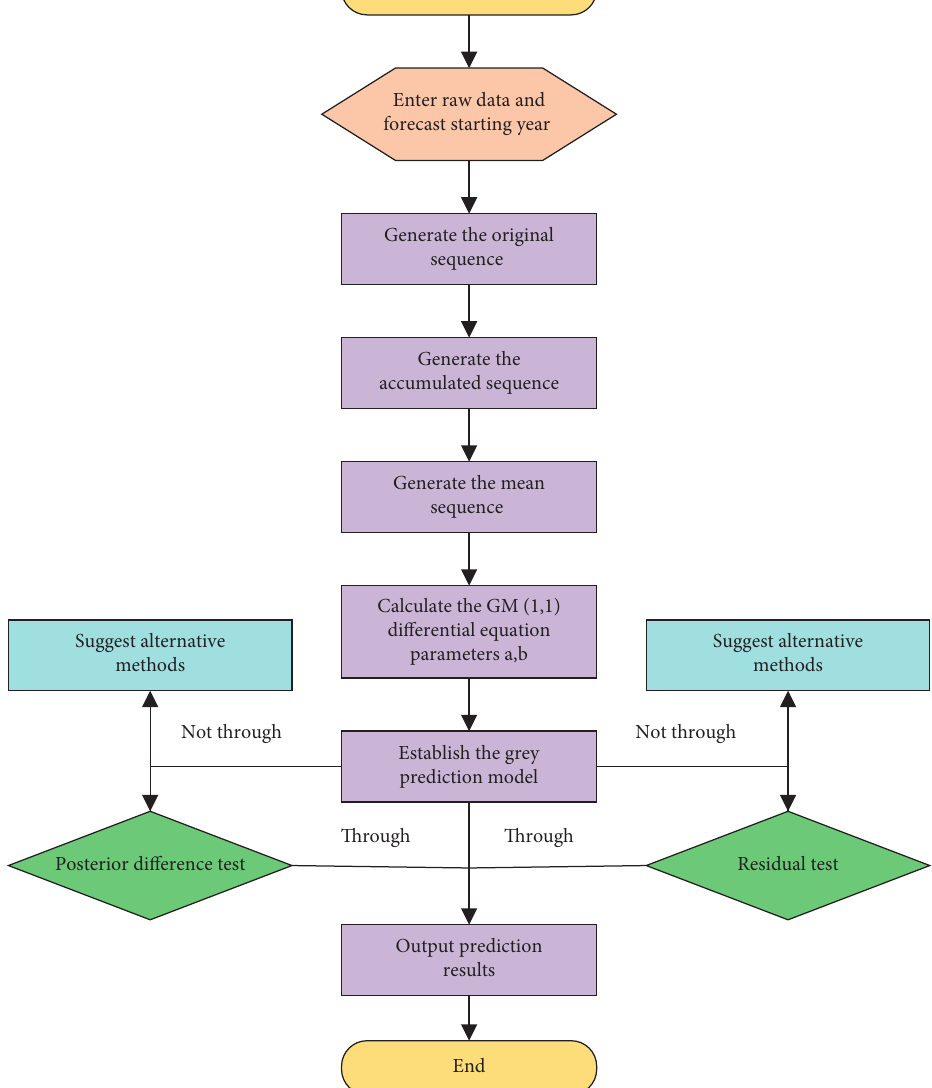
Figure 2: Modeling flowchart of the grey prediction